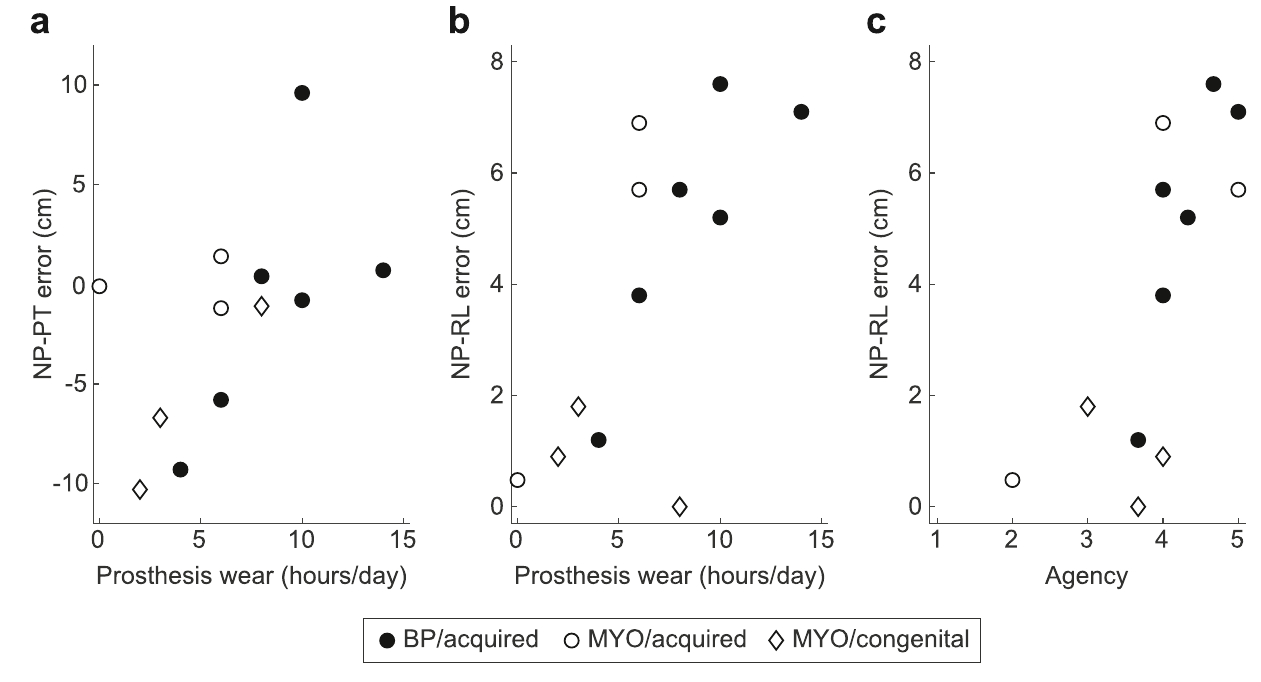
Figure 4. Correlations between limb length error and participant characteristics. Correlations between ( a ) NP-PT error and hours of daily prosthesis wear, ( b ) NP-RL error and hours of daily prosthesis wear, and ( c ) NP-RL and agency